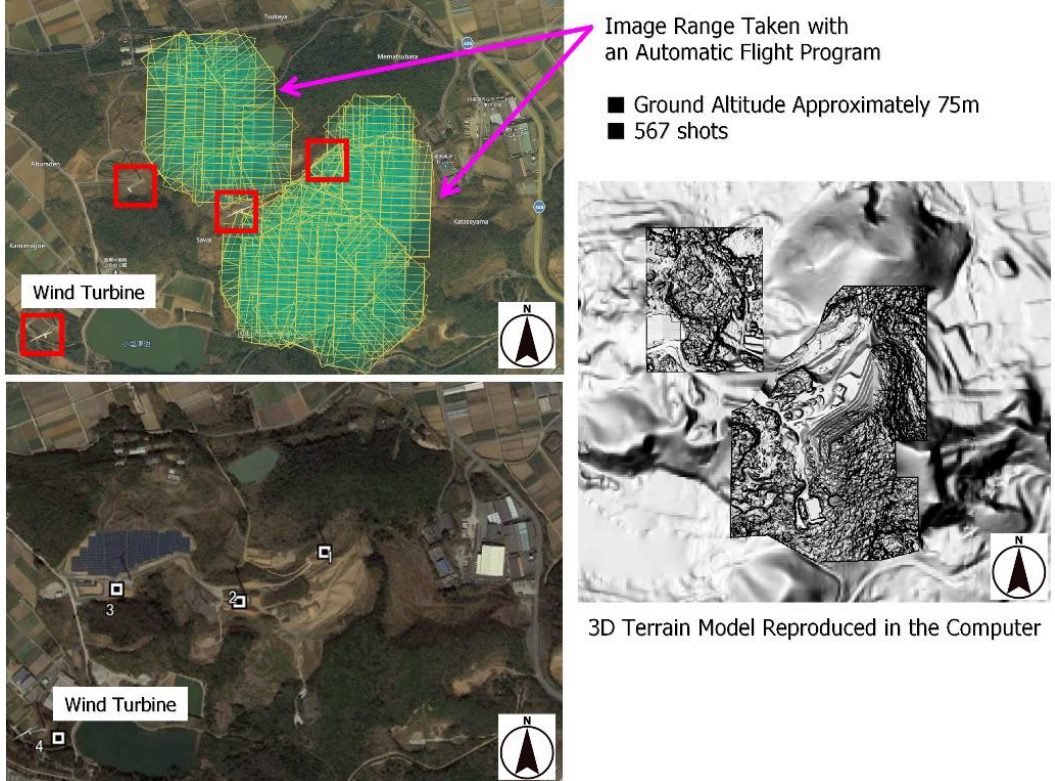
Figure 6. Construction of high-resolution elevation data with a drone.